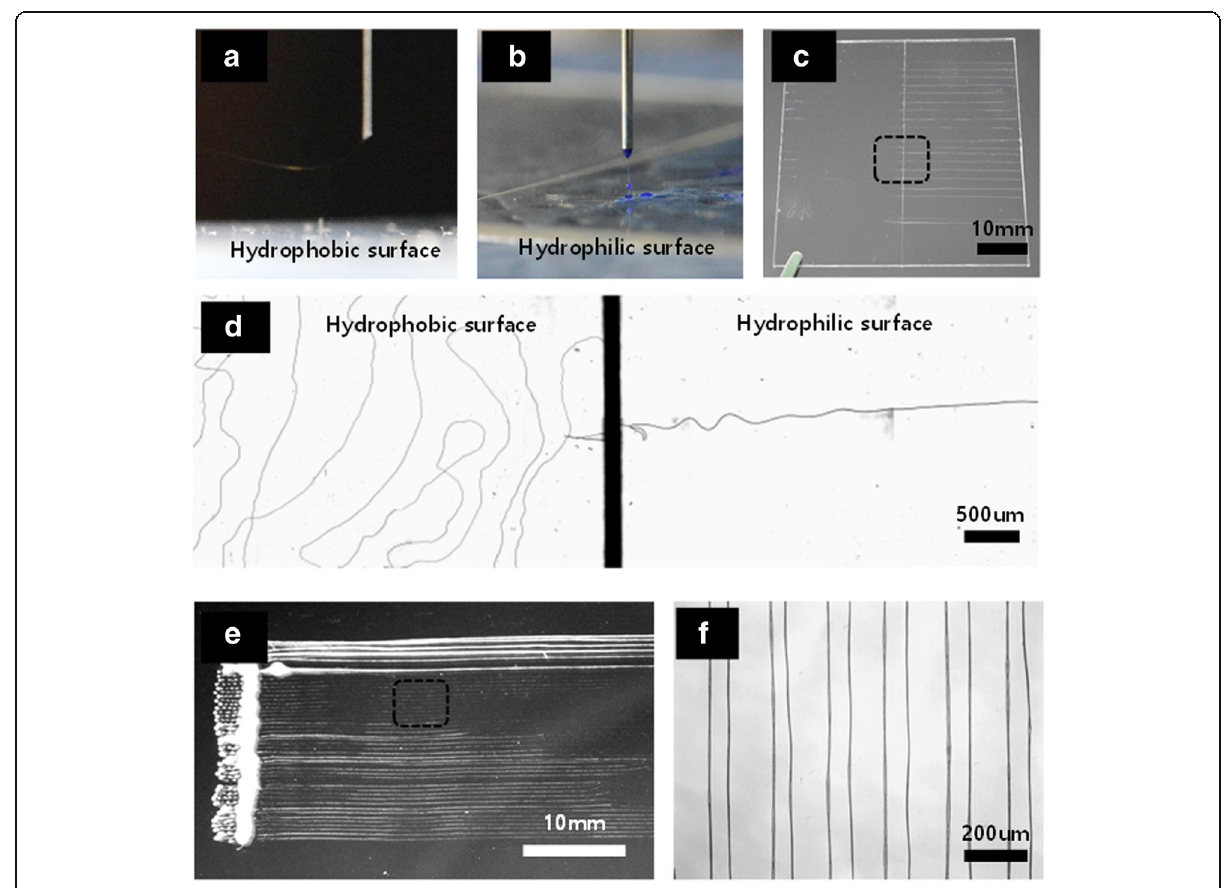
Fig. 6 Images of near-field electrospun films on a a hydrophobic surface and b a hydrophilic surface. Images of polymer fibers written directly onto a polymer substrate with a hydrophobic surface (left) and a hydrophilic surface (right); c a digital camera photograph and d a digital micrograph. Images of electrospun polymer fibers written directly on a hydrophilic surface; e a digital camera photograph and f a digital